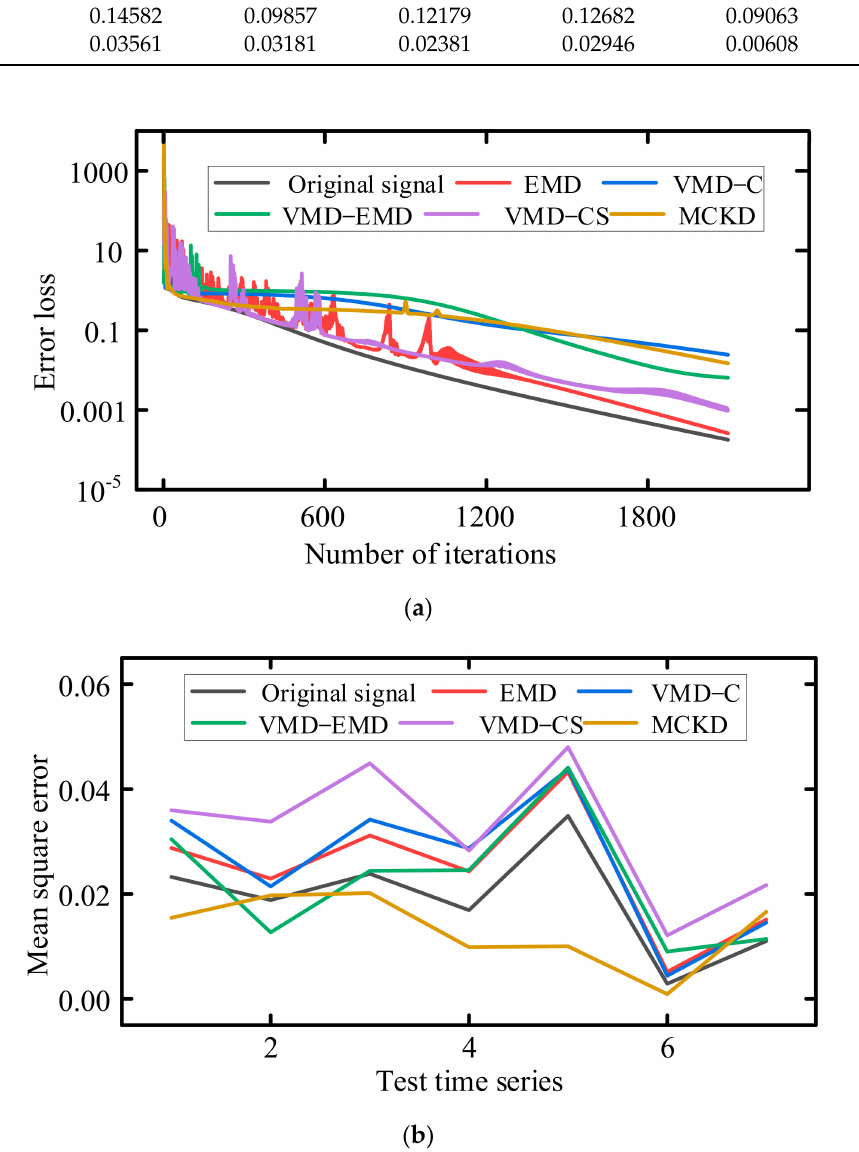
Figure 9. Error loss and mean square error comparisons for different models. ( a ) Error loss for different models. ( b ) Mean square error for different